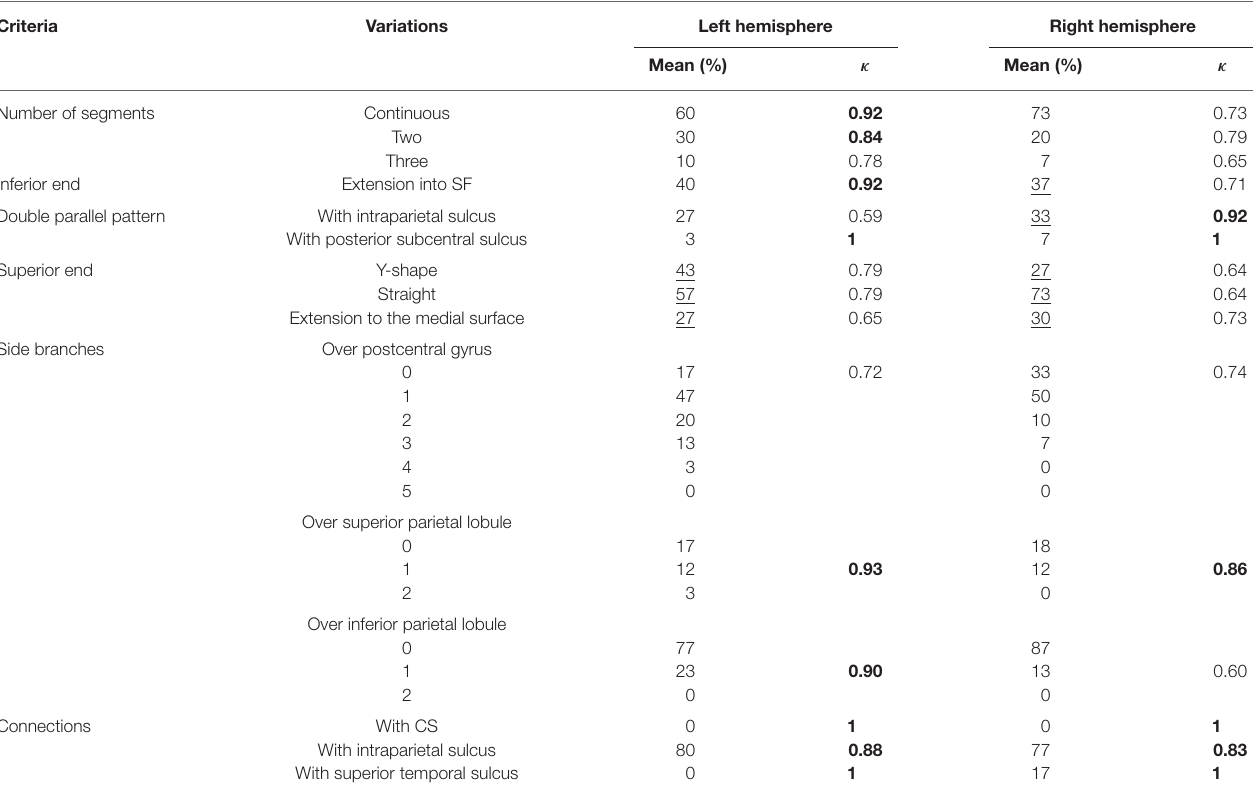
TABLE 6 | Mean occurrence frequency and inter-rater concordance of each criterion of the postCS in the left and right hemispheres.